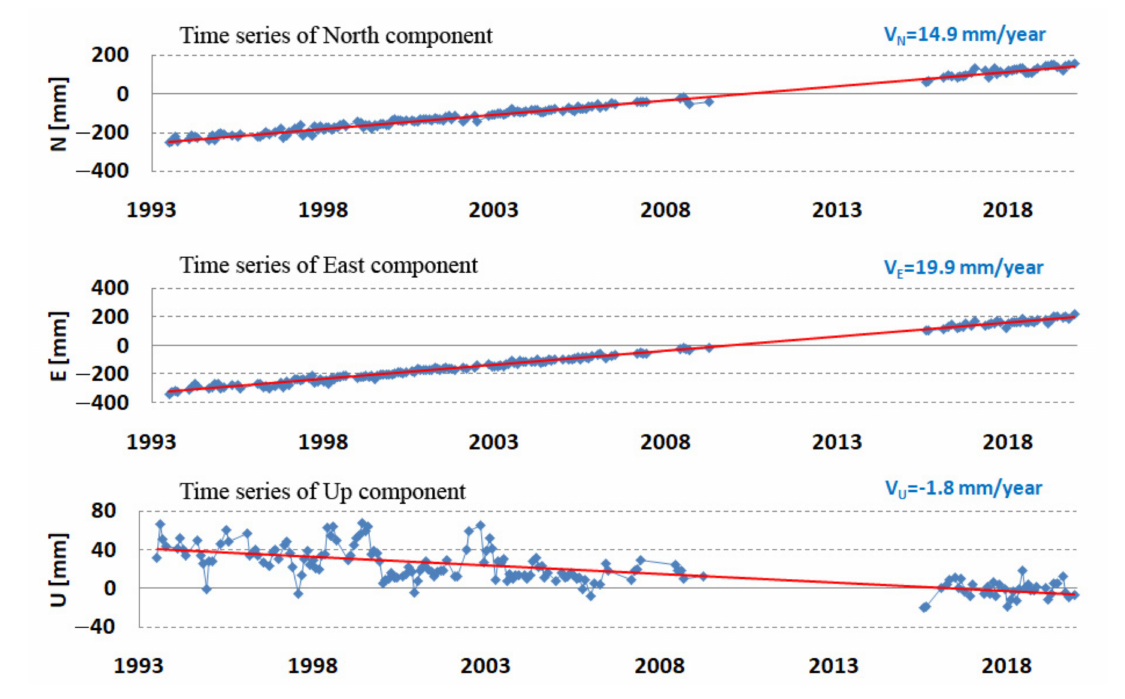
Figure 11. Borowiec SLR station—topocentric coordinates N, E, U (mm) in 1993–2019. Table 7. The velocities of Borowiec SLR station (7811) in